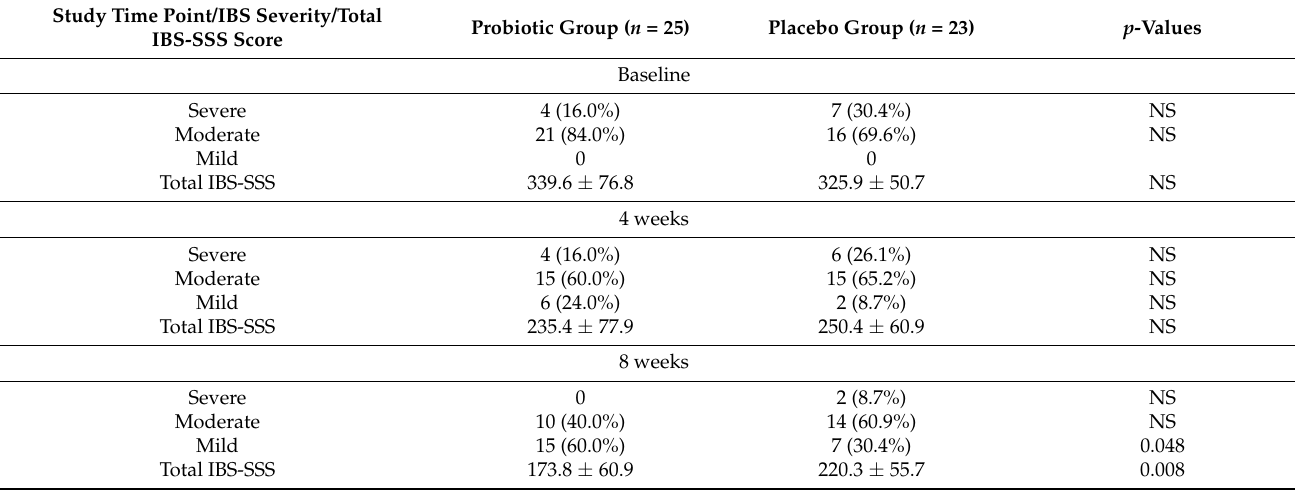
Table 3. Changes in IBS severity assessed with the use of the